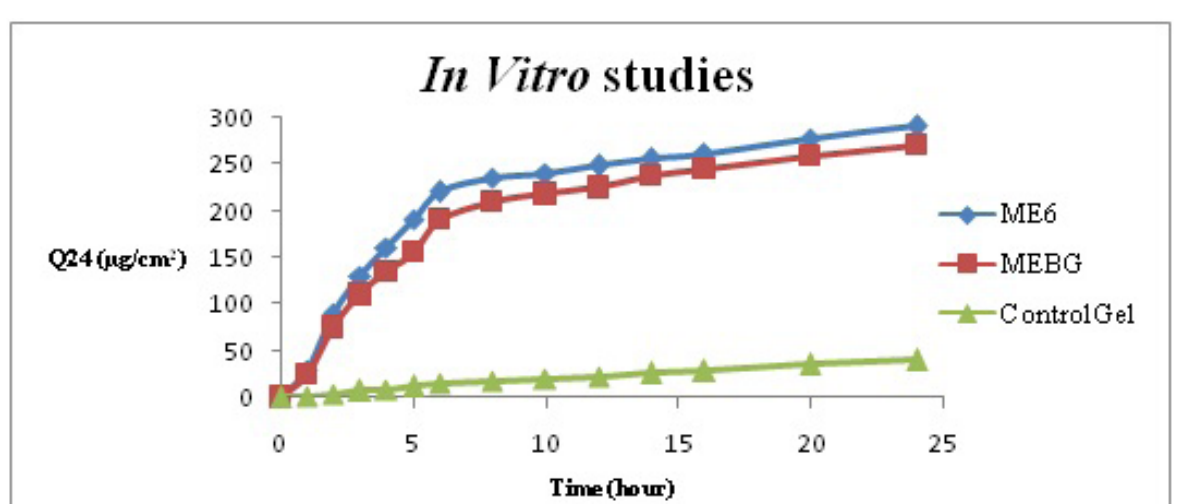
Figure 3. In vitro permeation profiles of Celecoxib loaded ME